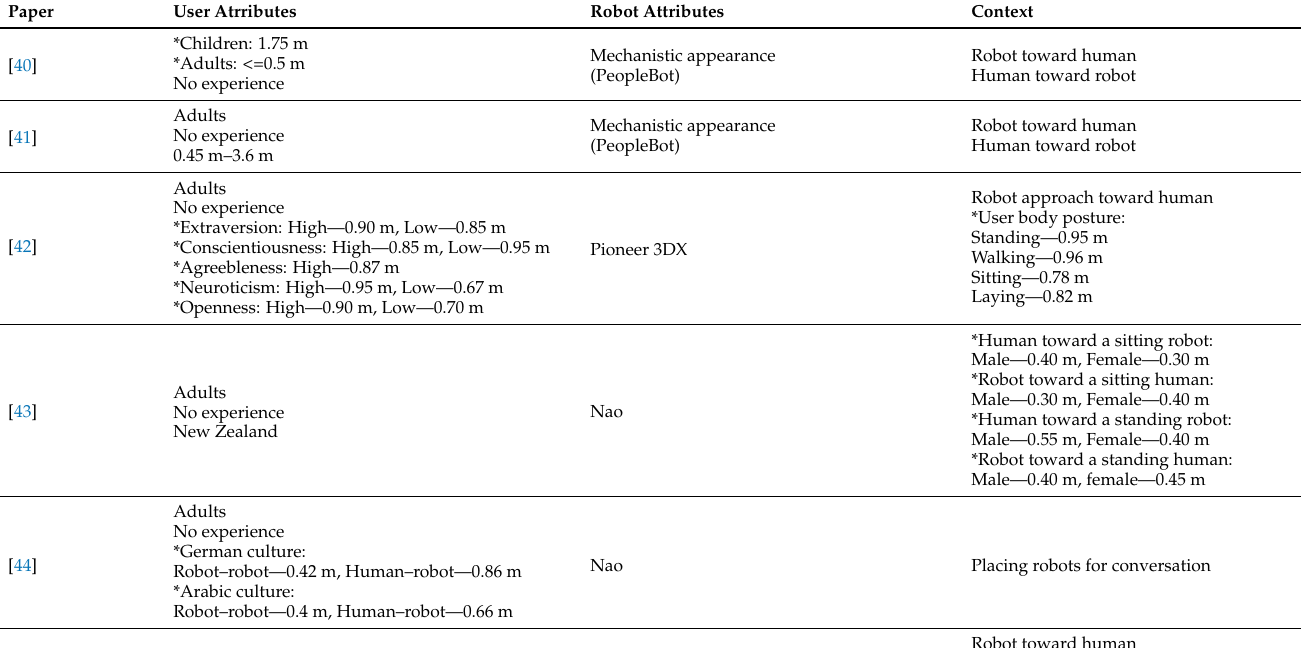
Table 1. HRP preferences revealed by human–robot explanatory